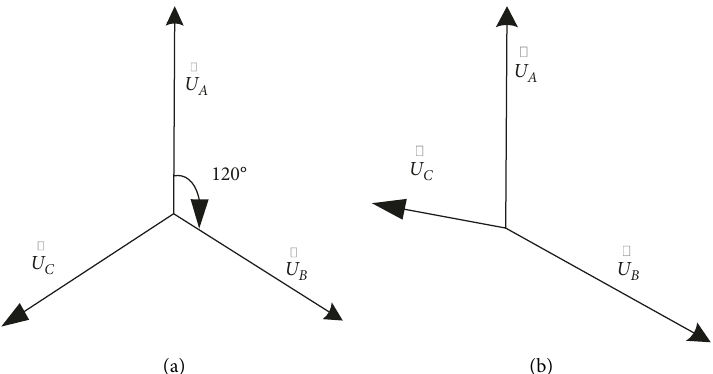
Figure 1: Three-phase voltage phasor diagram: (a) ideal three-phase voltage vector and (b) unbalanced three-phase voltage